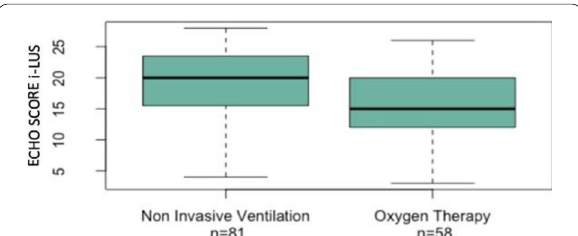
Fig. 4 Boxplot—ECHO SCORE i-LUS and support of the respiratory function